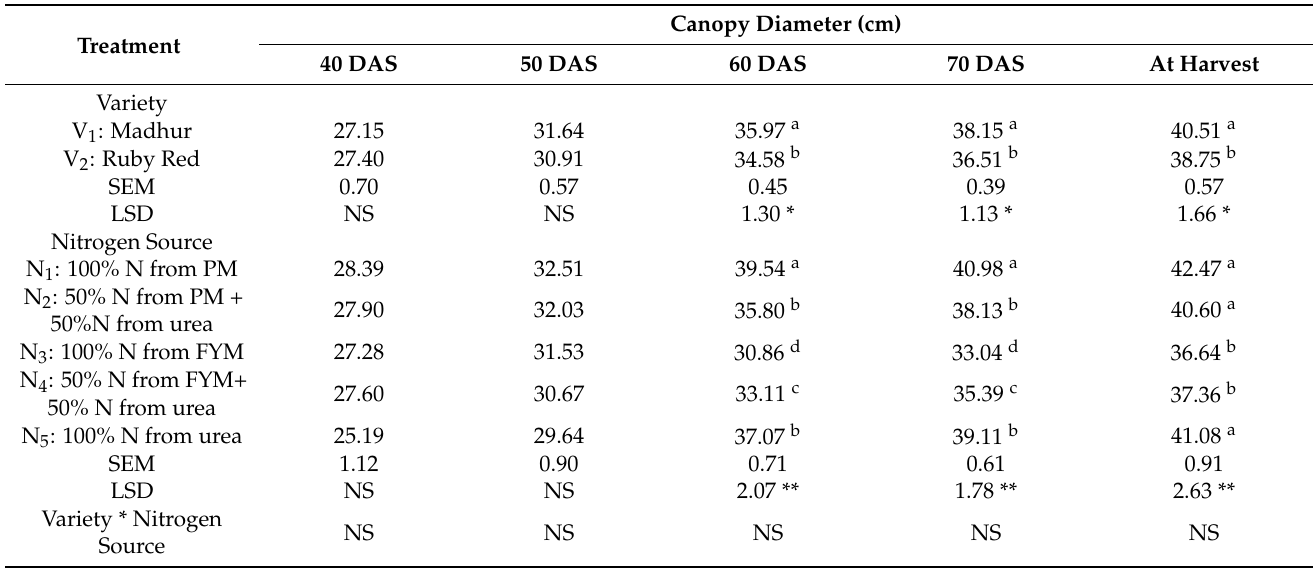
Table 3. Effect of variety and nitrogen source on canopy diameter at different stages of beetroot at AFU, Rampur, Chitwan in